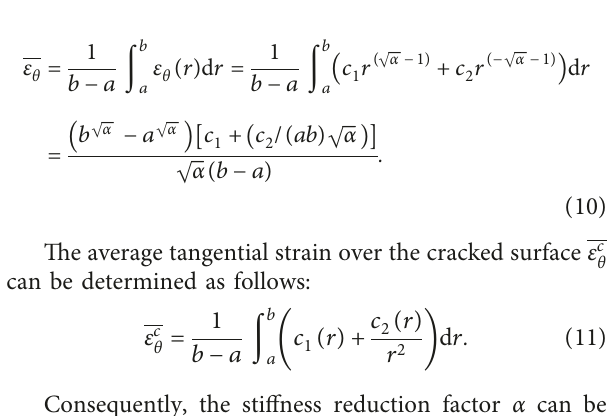
Figure 2: Model for calculation of initial crack